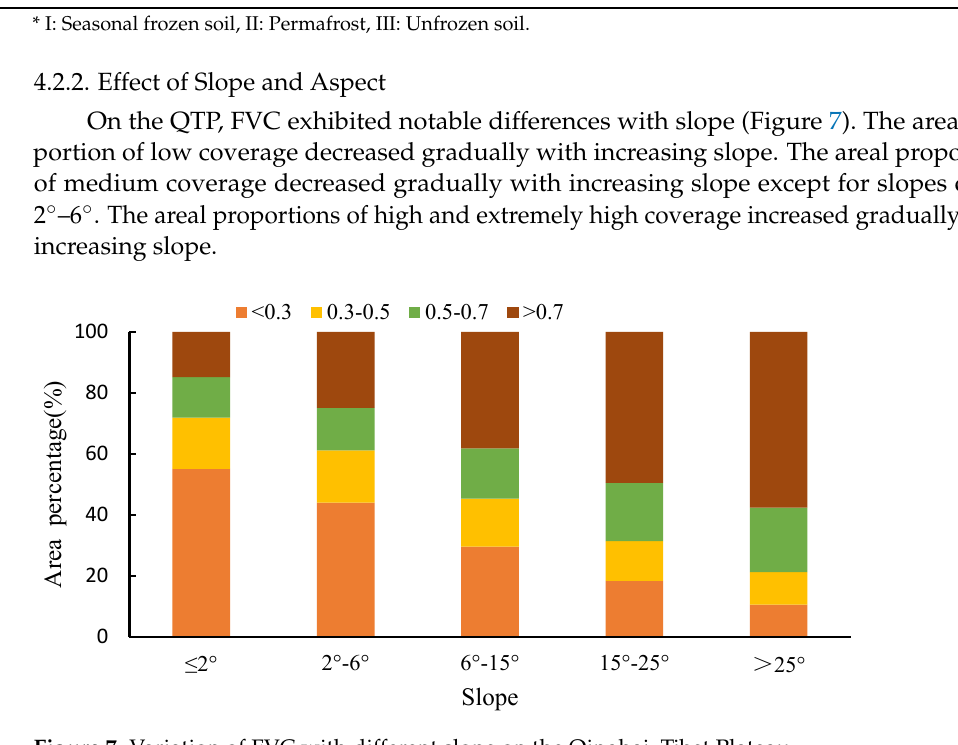
Figure 7. Variation of FVC with different slope on the Qinghai–Tibet Plateau.